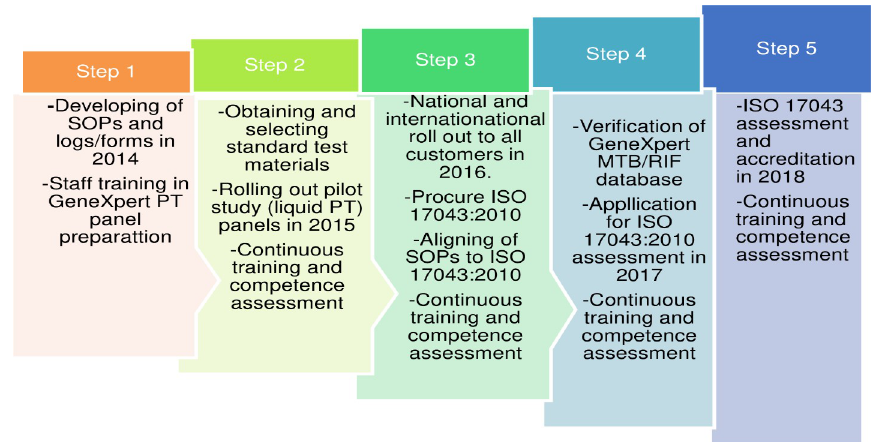
Fig 1. Roadmap for establishing GeneXpert PT scheme in